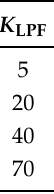
Table 5. Time constants depending on LPF